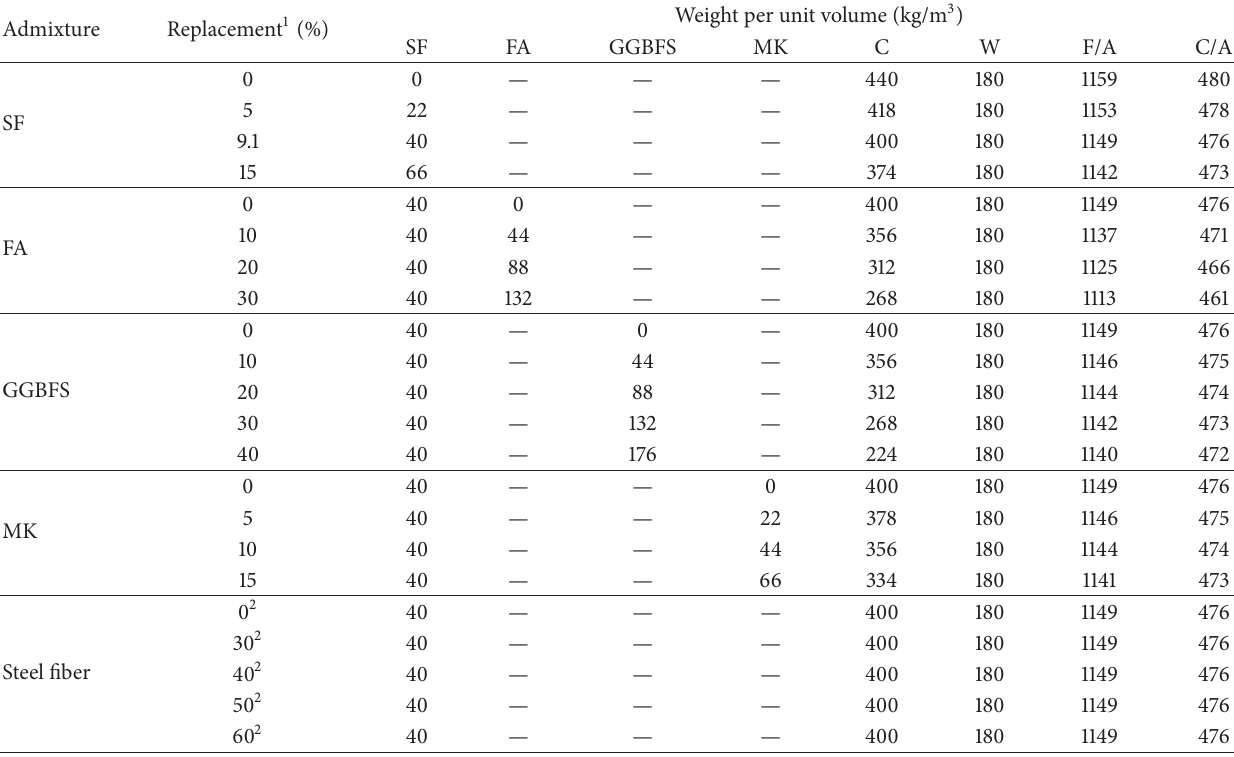
Table 1: Mixture proportions of